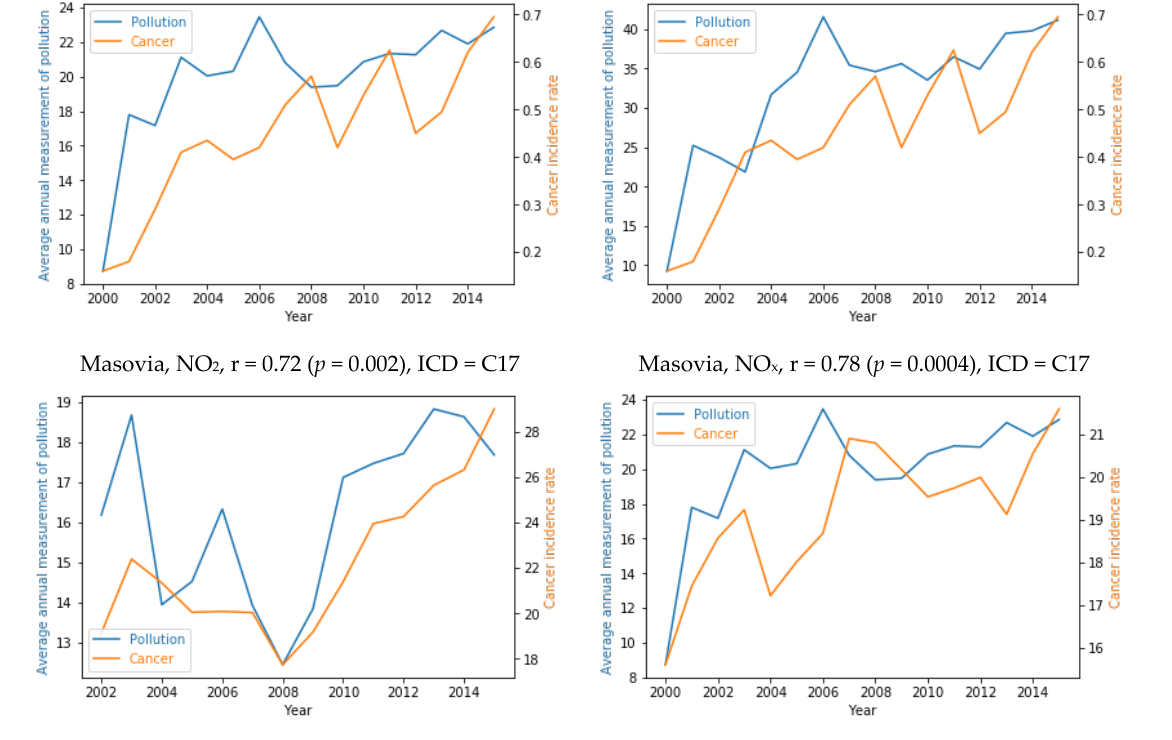
Figure 5. Level of nitrogen oxide emissions (µg/m 3 ) with the formation of bowel cancer, where r stands for the Pearson correlation coefficient and ICD is the International Classification of Diseases code.